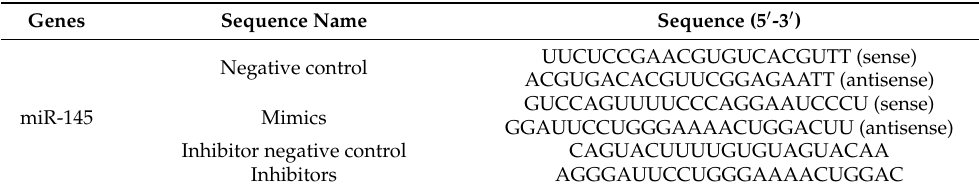
Table 2. RNA oligonucleotide sequence